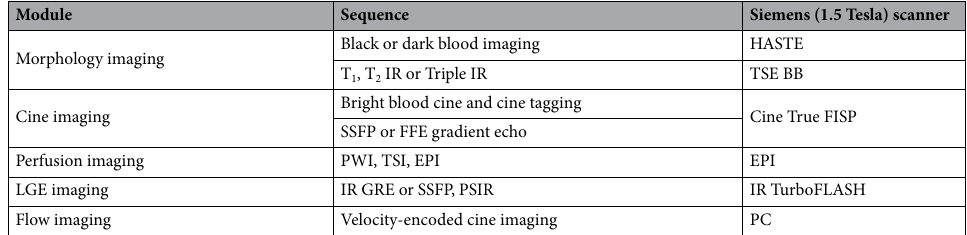
Table 1. CMRI sequences in IHD patients using Siemens (1.5 Tesla) scanner. Black blood BB , Echo planar imaging EPI , Fast field echo-steady state free precession FFE-SSFP , Fast imaging with steady state precession FISP , Fast low angle shot FLASH , Gradient echo GRE , Half-Fourier acquisition single-shot turbo spin-echo HASTE , Inversion recovery IR , Late gadolinium enhancement LGE , Phase contrast PC ,